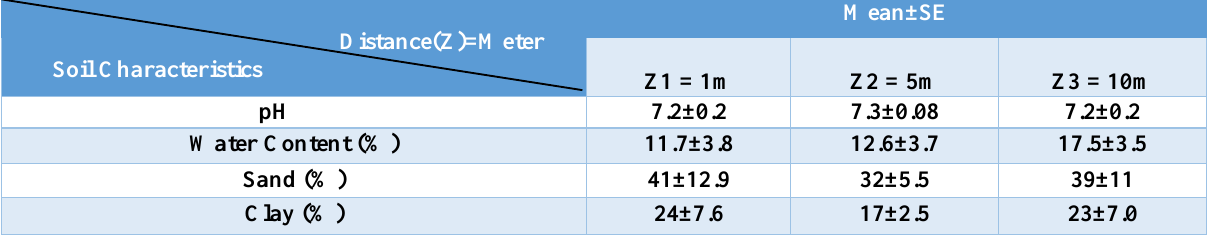
Table, 2: Comparison (mean ±SE) of the physico-chemical characteristics of the soil at different distance (Z1, Z2, and Z3) collected from the right (R) side of the farm